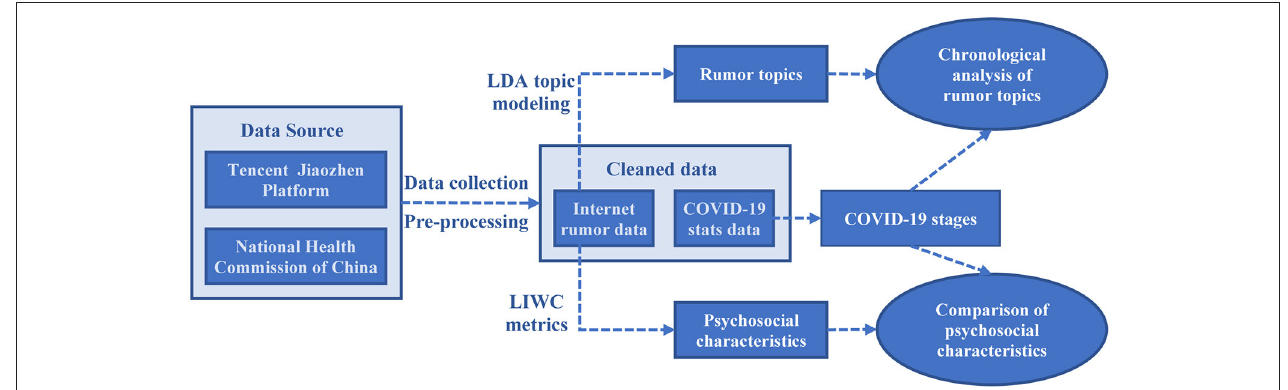
FIGURE 1 | Research